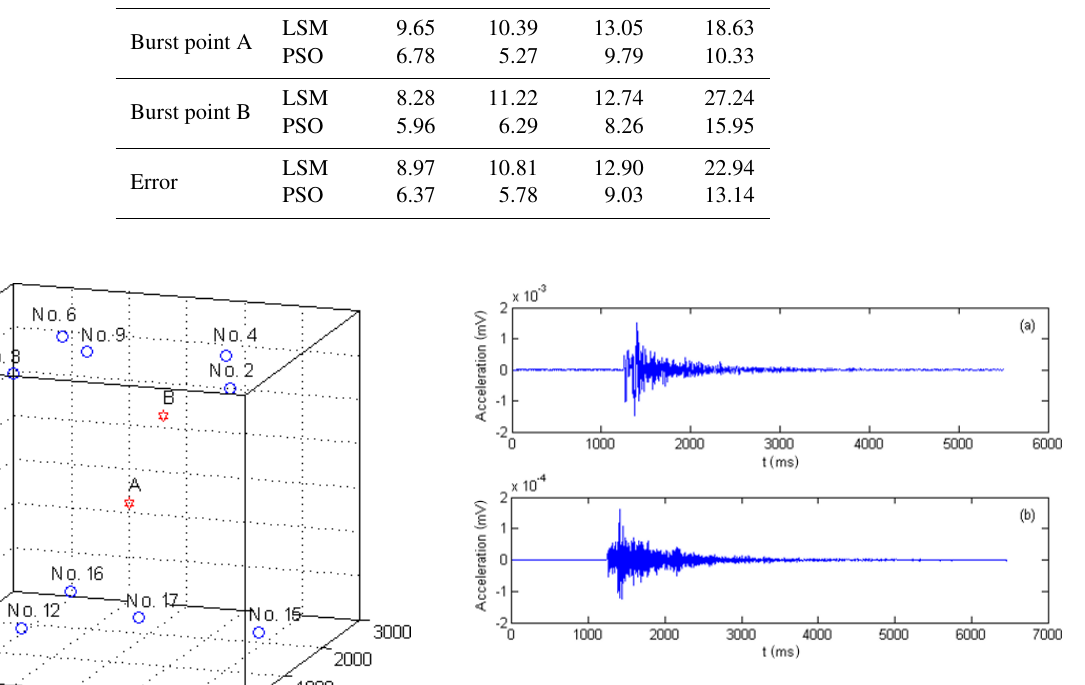
Figure 6. (a) Seismic waveform of burst point A received by geo- phone no. 2. (b) Seismic waveform of burst point B received by geophone no.